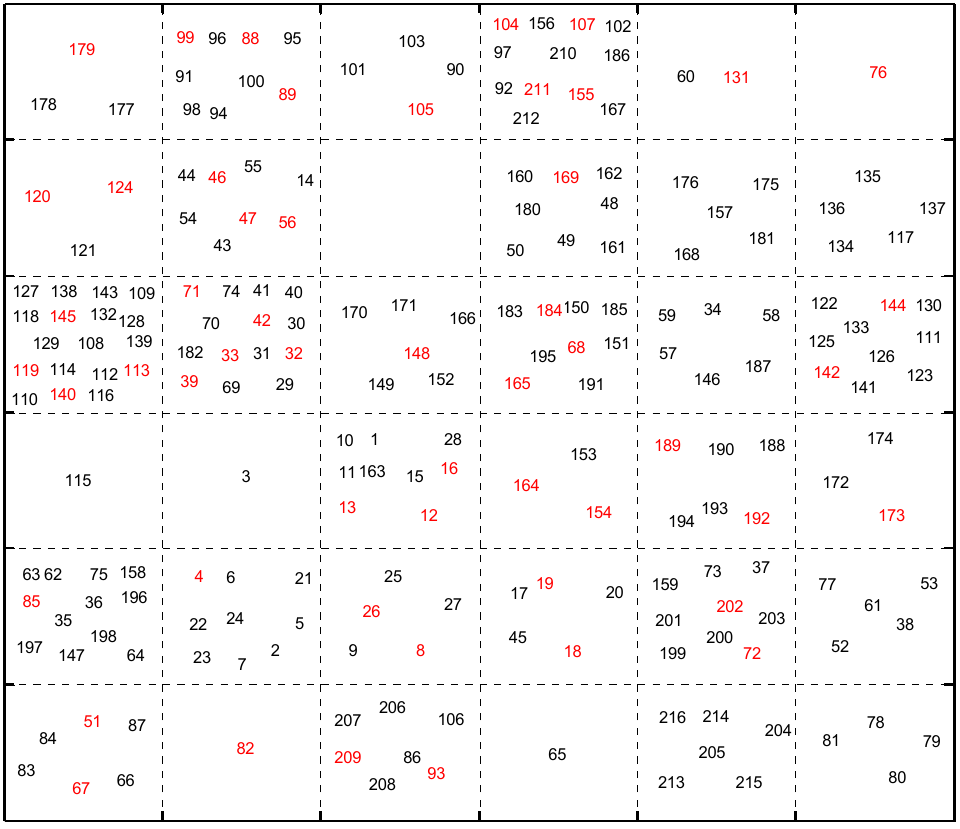
Figure 1 . Self-organizing map (SOM) top map indicating the distribution of the training and external prediction sets. The training set is labeled in black font and the prediction set in red font. The number corresponds to the series number of the compounds of the RSV